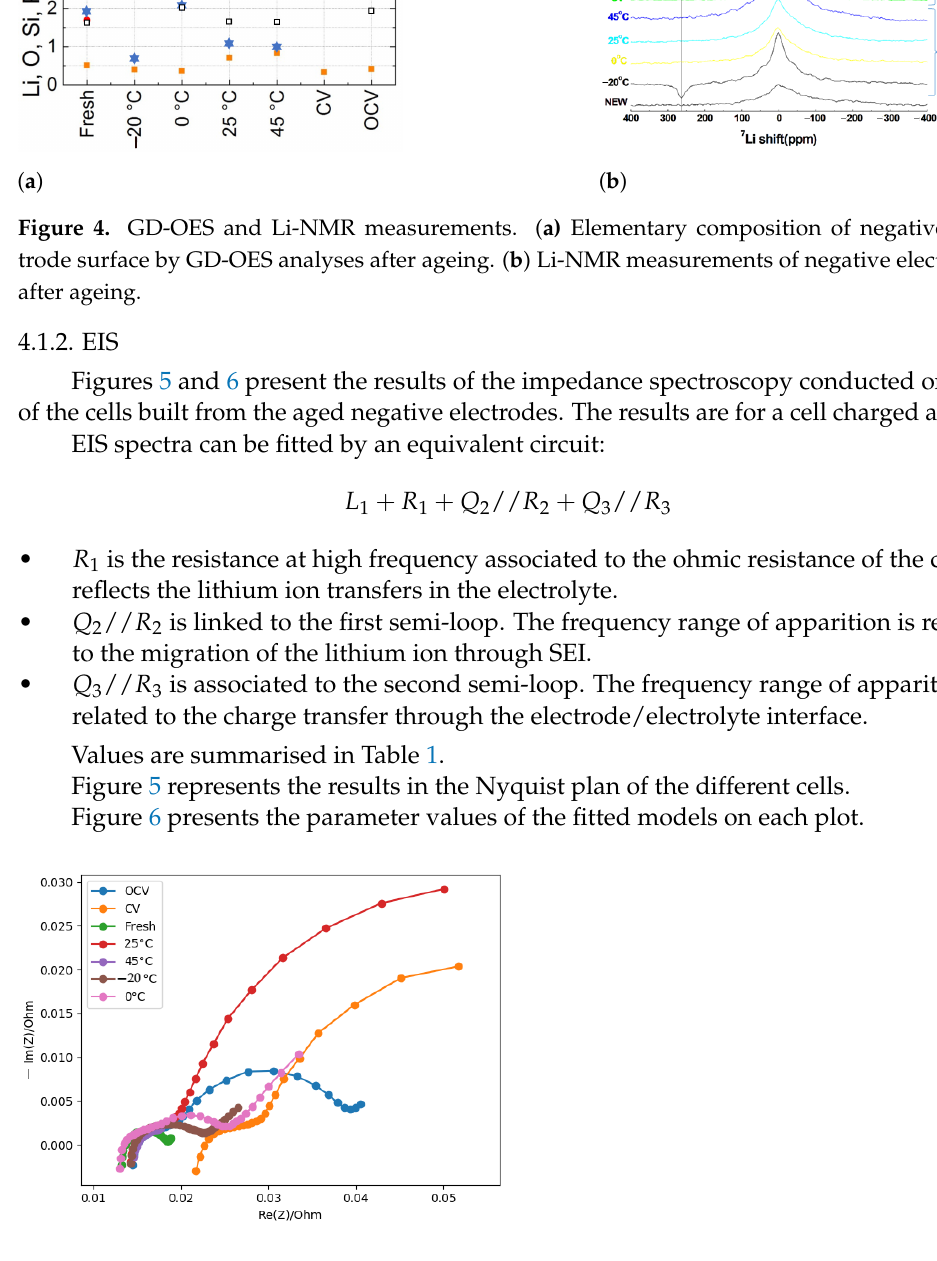
Figure 5. Nyquist plot of the different cells at SOC =